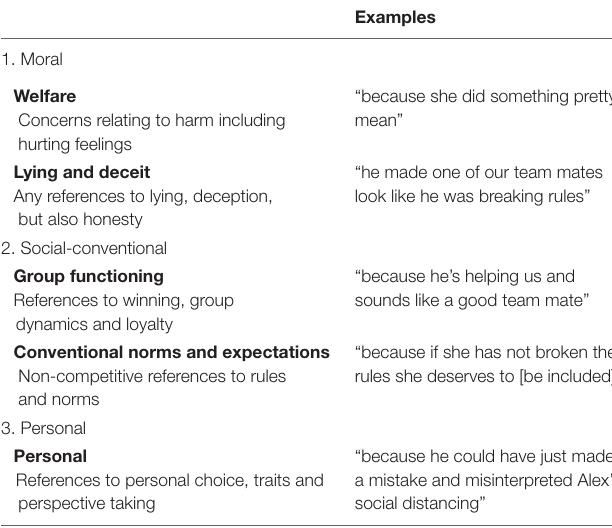
TABLE 1 | Social-moral reasoning categories, with examples of participant responses for each of the subcategories which are in